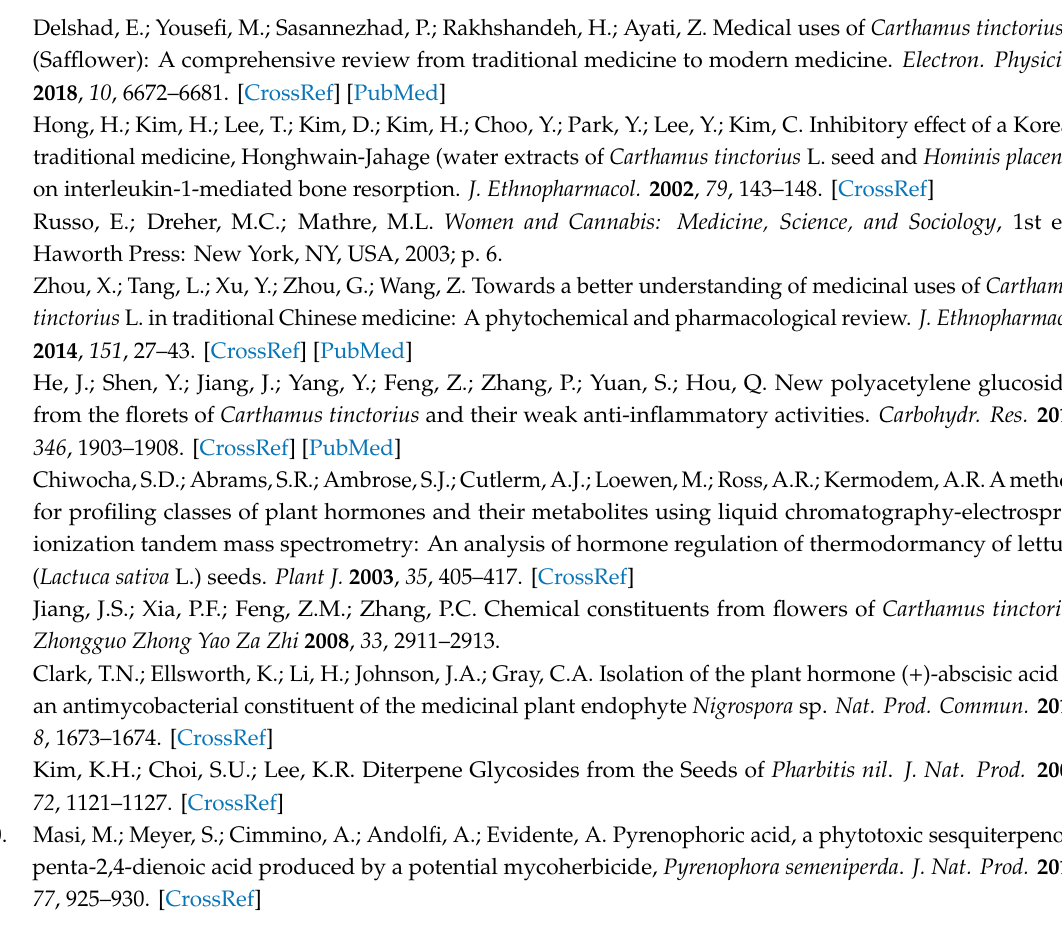
charge. Figure S1: The HRESIMS data of 1 , Figure S2: The 1 H NMR spectrum of 1 (CD 3 OD, 850 MHz), Figure S3: The 1 H- 1 H COSY spectrum of 1 , Figure S4: The HSQC spectrum of 1 , Figure S5: The HMBC spectrum of 1 , Figure S6: The ROESY spectrum of 1